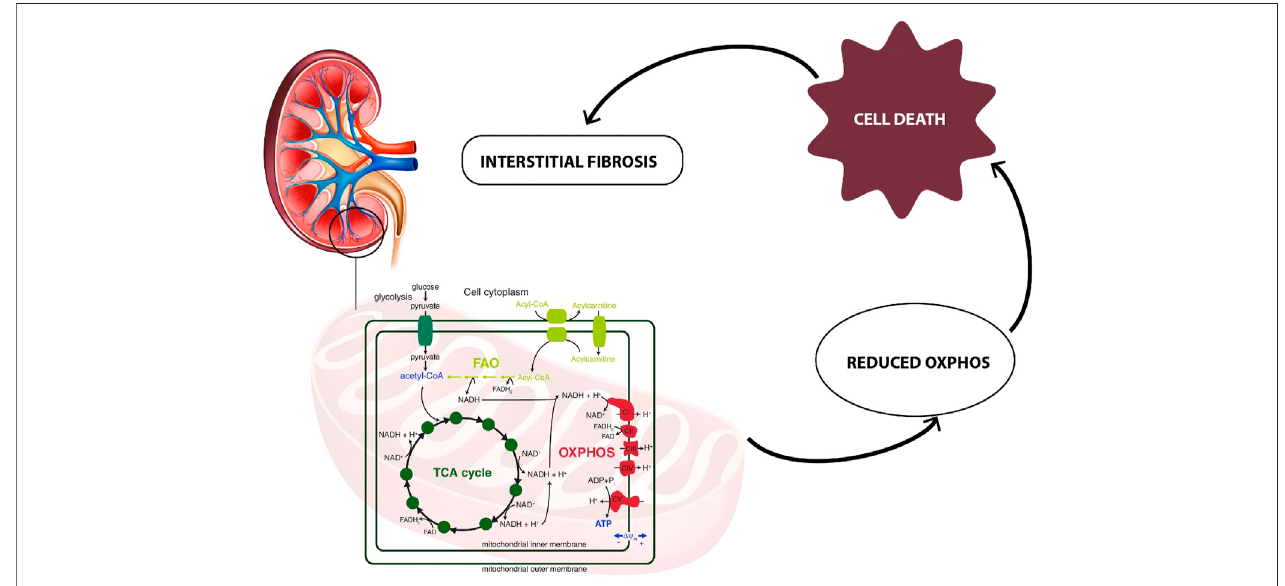
FIGURE 5 | Relationship between metabolic reprogramming of mitochondrial metabolism (FAO, OXPHOS) and kidney interstitial fi